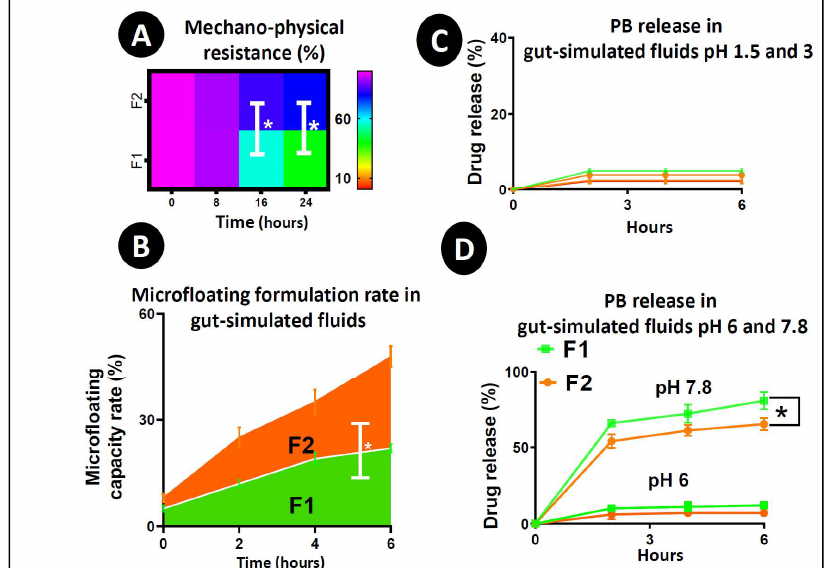
Figure 3. ( A ) Microcapsules mechanical strength testing; control (F1) and test (F2); ( B ) microcapsules buoyancy index. ( C – D ) Microcapsules dissolution profiles in simulated gastric media at pH 1.5, pH ( C ); pH 6, pH 7.8; ( D ). N = 3, mean ± SEM. F1: PB–LVSA microcapsules and F2: PB–ULCA–LVSA microcapsules.